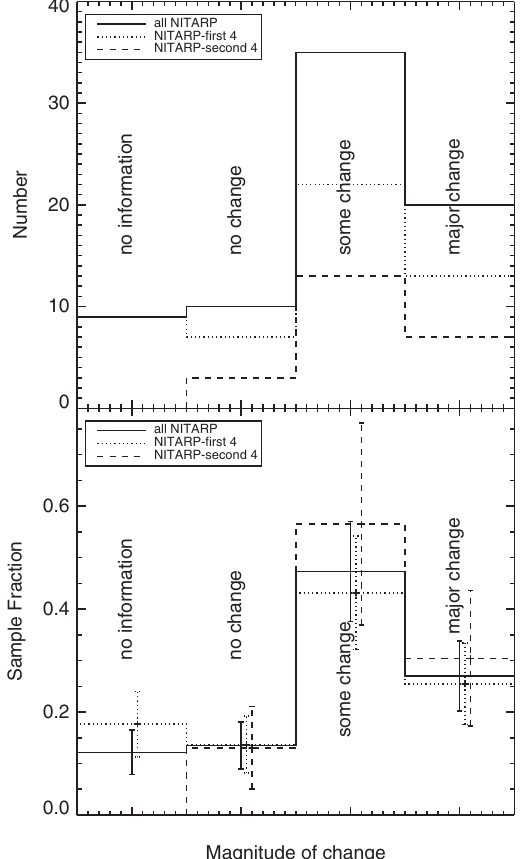
FIG. 1. Numbers (top) and fractions (bottom) of educators who report changes in their understanding of the nature of science. The first bin is those educators for whom there is no information, the second bin is those reporting no change in understanding, the third bin is those reporting some change in understanding (a more nuanced understanding), and those who report a major change in understanding. Because the wording of our questions changed, plotted here are the aggregate counts (solid line), but also the first four years of NITARP ( “ NITARP-first 4 ” , dotted line), as distinct from the second four years of NITARP ( “ NITARP-second 4 ” , dashed line). Errors shown in the second panel assume Poisson statistics, and are slightly offset for clarity. About 74% ( (cid:3) 13% ) of educators report either some or a major change in their under- standing of the nature of